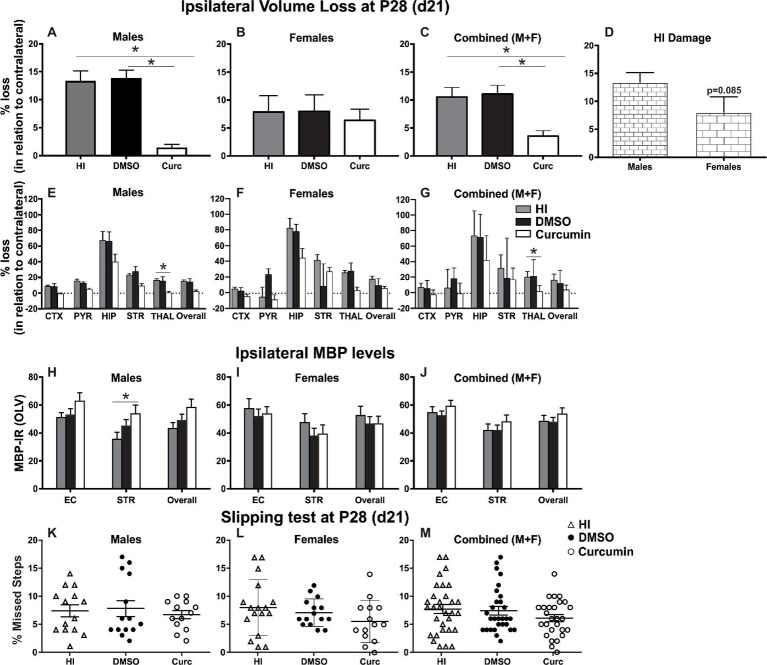
Intraperitoneal injection of curcumin in P7 mice post-HI reduces ipsilateral volume loss in males, females and combined (males + females), decreases myelin loss in males, but does not provide functional protection assessed through slipping test. (A) Intraperitoneal injection of 200 μg/g curcumin straight after HI decreased tissue loss at 21 days post HI (P28) in males compared to DMSO-treated littermates and untreated HI controls (curcumin n = 11, DMSO n = 8, HI n = 9; curcumin vs. HI p = 0.0017, curcumin vs. DMSO p = 0.0003). (B) Curcumin treatment at 200 μg/g straight after HI did not affect tissue loss at 21 days post HI in females compared to DMSO-treated littermates or to untreated HI controls. (curcumin n = 8, DMSO n = 7, HI n = 8). (C) The levels of tissue loss in the curcumin treated animals decreased compared to DMSO-treated littermates and untreated HI controls (curcumin n = 19, DMSO n = 15, HI n = 17; curcumin vs. HI p = 0.0024, curcumin vs. DMSO p = 0.0014). (D) The level of tissue loss observed in females was lower compared to the males, however the differences did not reach significant values (p = 0.085). This suggests higher susceptibility of the males to HI insult. (E–G) Subregional assessment of tissue loss at 21 days post HI in males (E, curcumin n = 11, DMSO n = 8, HI n = 9), females (F, curcumin n = 8, DMSO n = 7, HI n = 8) and combined (males + females) (G, curcumin n = 19, DMSO n = 15, HI n = 17). Curcumin treatment with 200 μg/g immediately post HI resulted in a reduction of subregional tissue loss in all studied regions in males (E) and combined (males + females) (G) with significant differences observed in thalamus (males p = 0.0292, combined (males + females) p = 0.0242). (F) Curcumin treatment had no effect on subregional differences in tissue loss in females. (H–J) MBP immunoreactivity at 21 days post HI (P28). Quantification of the ipsilateral external capsule, striatum, and overall in optical luminosity values (OLV, Mean + SEM). (H) In males curcumin treatment with 200 μg/g immediately post HI resulted in increased levels of MBP immunoreactivity compared to untreated HI controls (curcumin n = 11, DMSO n = 8, HI n = 9), with significant differences in striatum (Two-way ANOVA with post hoc Tukey’s test, p = 0.042). In females (I, curcumin n = 8, DMSO n = 7, HI n = 8) and combined (males + females) (J, curcumin n = 19, DMSO n = 15, HI n = 17), immediate treatment with 200 μg/g curcumin had no effect on MBP immunoreactivity. (K–M) Curcumin treatment with 200 μg/g immediately post HI did not affect the number of missed steps (slipping test) at 21 days (P28) post HI in males (K, curcumin n = 13, DMSO n = 14, HI n = 14), females (L, curcumin n = 14, DMSO n = 15, HI n = 17) and combined (males + females) (M, curcumin n = 27, DMSO n = 29, HI n = 31). (*p < 0.05). Abbreviations: CTX, cerebral cortex; EC – external capsule; HIP – hippocampus; PYR, pyriform cortex; STR, striatum; THAL, thalamus.